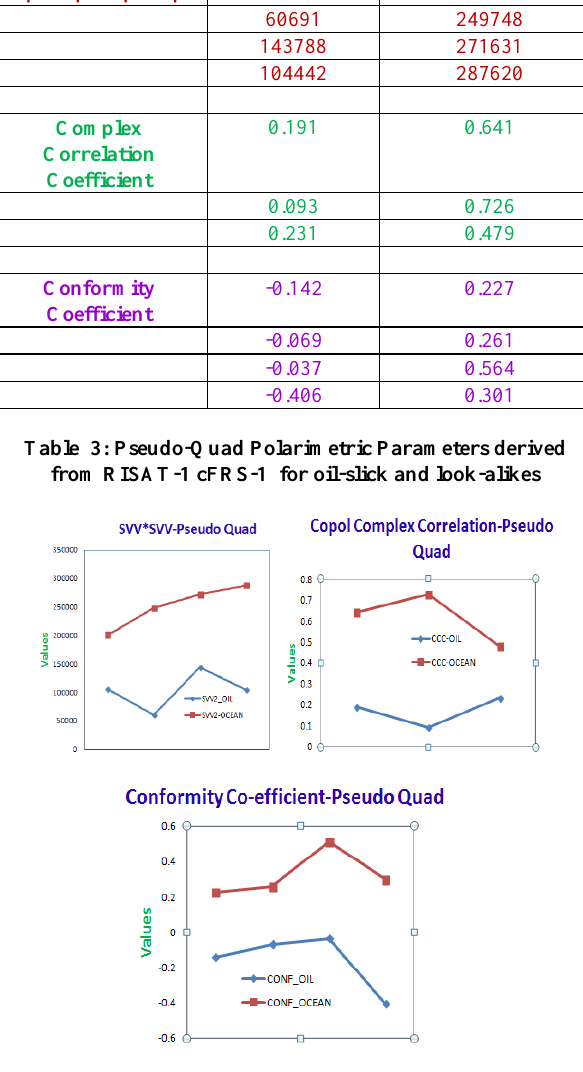
Figure 4: Pseudo-Quad polarimetric parameters for oil slick and ocean/look-alike signatures The pseudo-quad pol covariance matrix is constructed and the relevant oil-spill parameters like <S VV2 >,complex correlation coefficient and conformity are derived and tabulated.The values of <S VV2 > are lower for oil-slick and higher for lookalikes because of damping caused by oil on the V-pol component.The copol correlation is lesser in the case of oil and more in the case of look-alike/clean sea.The conformity is negative for oil and positive for the ocean surface.All these observations are in accordance with theoretical values and experimental